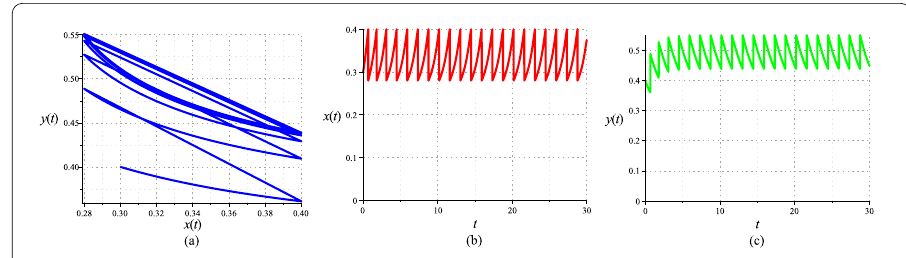
Figure 7 Numerical simulations in Case I. ( a ) Phase portrait of x ( t ) and y ( t ) on h = 0.4. ( b ) Time series of x ( t ). ( c ) Time series of y ( t )